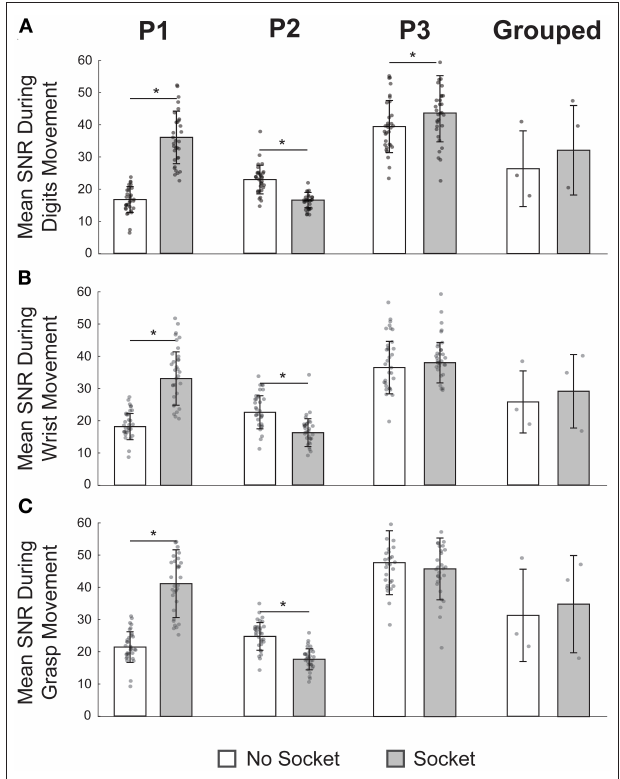
FIGURE 3 | Signal-to-noise ratio (SNR) was not affected by the functional-test socket in aggregate but varied for each participant individually. (A) Mean SNR during movement of individual digits was significantly different at the individual level when wearing the socket but not so for the grouped case. (B) During wrist movements, SNR was significantly different for P1 and P2 but not so for P3 or in the grouped case. (C) Once again, SNR varied significantly for P1 and P2 during grasping but was statistically equivalent for P3 and in the grouped case. * p -value < 0.05, paired t -tests; N = 32 for each P1, P2, P3 bar; N = 3 for each grouped bar; individual data points are overlayed on each